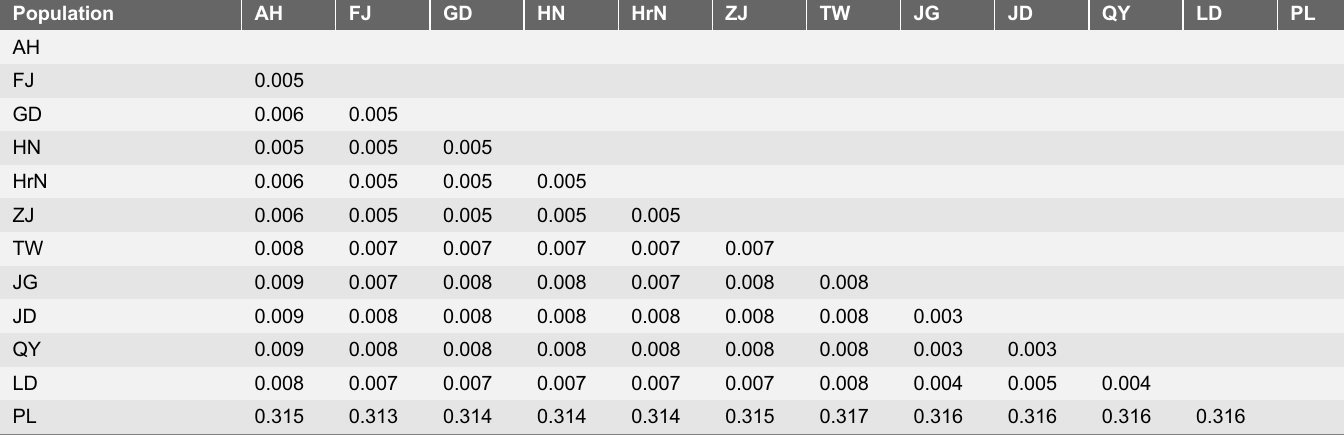
Table 3. Mean distance among tea green leafhopper populations based on combined datasets of COI and 16sRNA.